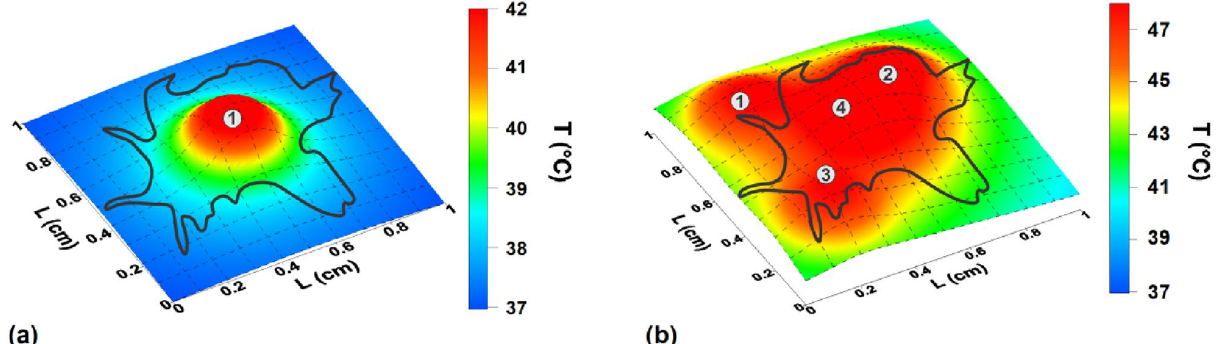
Figure 2. ( a ) The spatial temperature distribution in the central cross section, z = 0.5 cm, of a cube with size 1 cm created by a single heat source in the cube center; ( b ) the same for the case of four identical heat sources with centers lying in the plane z = 0.5 cm and marked with the points 1—4. The contours of an irregularly shape tumor in the given cross sections are shown by a black curve.